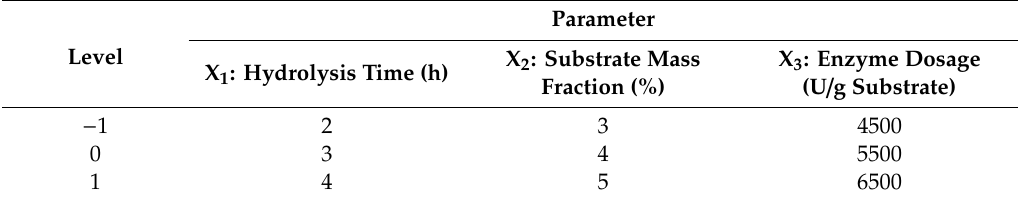
Table 4. Coded settings for the process parameters for hydrolysis, according to a BBD design of RSM.